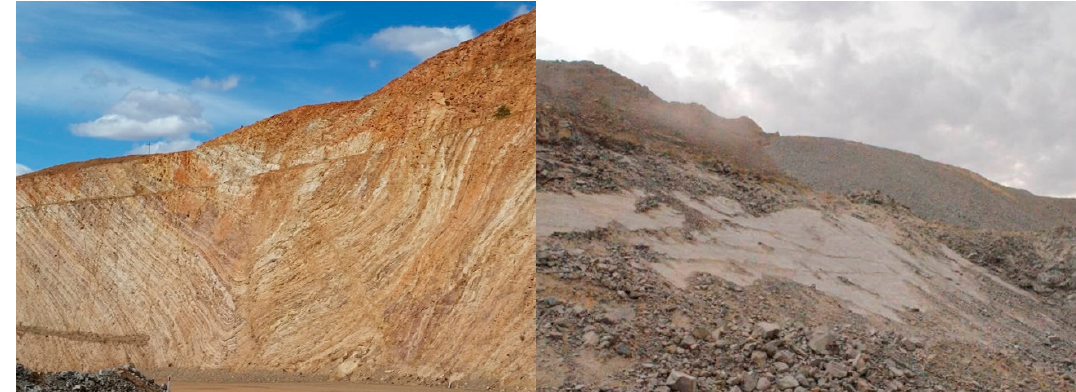
Figure 4. ( Left ): near-laminated weathered siltstone with siltstone-siltstone bedding planes (Telfer Gold mine, Australia). ( Right ): planar failure in fresh quartzite with quartzite-quartzite bedding planes (Telfer Gold Mine, Australia). Both have bedding scale anisotropy [28].